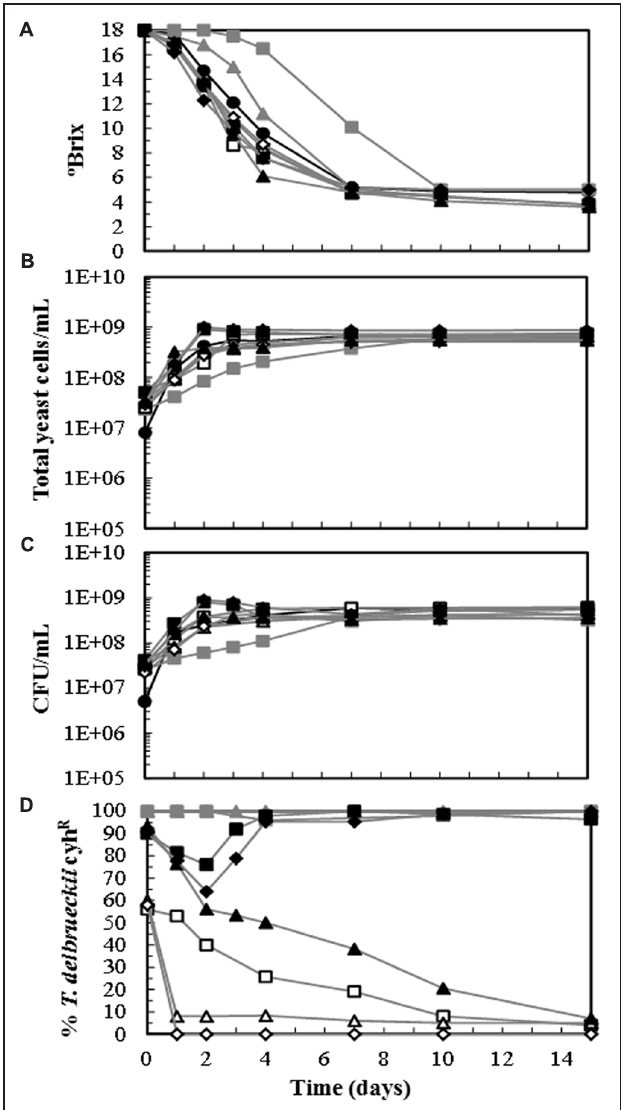
FIGURE 1 | Fermentation kinetic and yeast population dynamics of sterile-filtered and cold-settled Cigüente grape must inoculated with different yeast strains of Saccharomyces cerevisiae : EX85 (K2, cyh S ), or Torulaspora delbrueckii : EX1180-11C4 (Kbarr-1, cyh R )